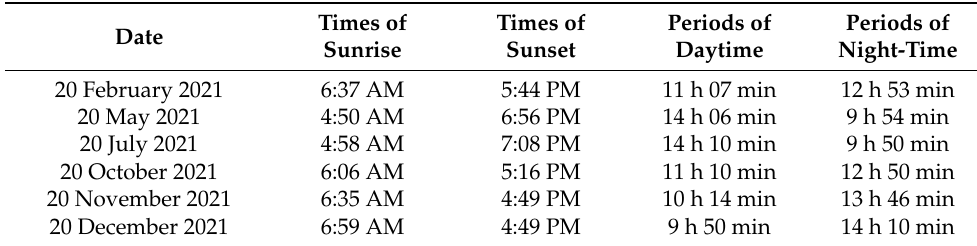
Times of sunrise (white arrows) and sunset (black arrows) for each month are shown in Figure 3. Table 3. The total number of progeny conidia collected from individual 20-day-old KSP-7N colonies in a single day during the periods of the daytime and the night-time for each month. The Number of Conidia The Number of Conidia Collected from a Single Colony Date Collected from a Single Colony at Periods of Night-Time * at Periods of Daytime *